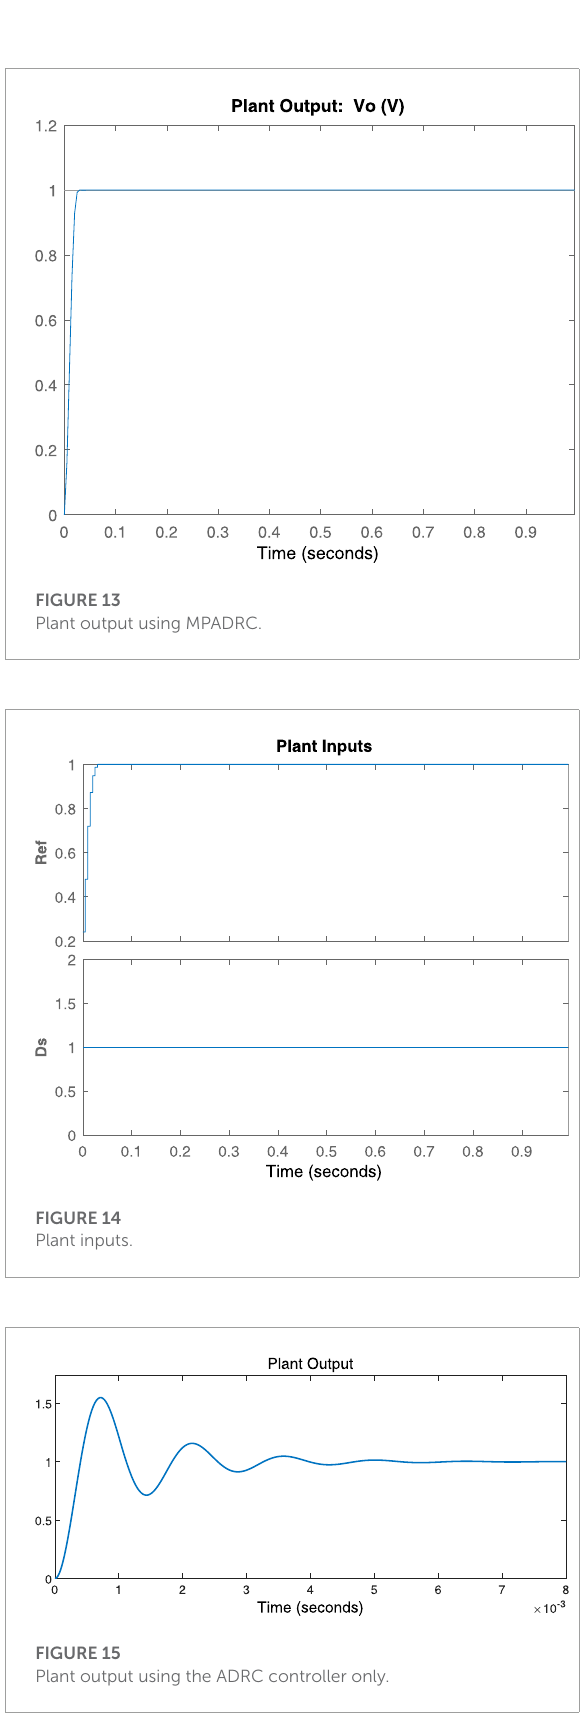
FIGURE 15 Plant output using the ADRC controller